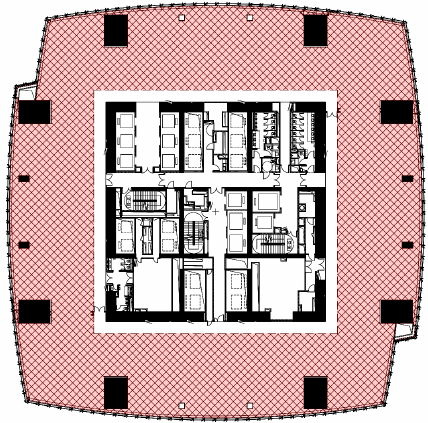
Figure 7. Legend of Rentable Area. Table 2. Definition of area indicators in China and the USA.